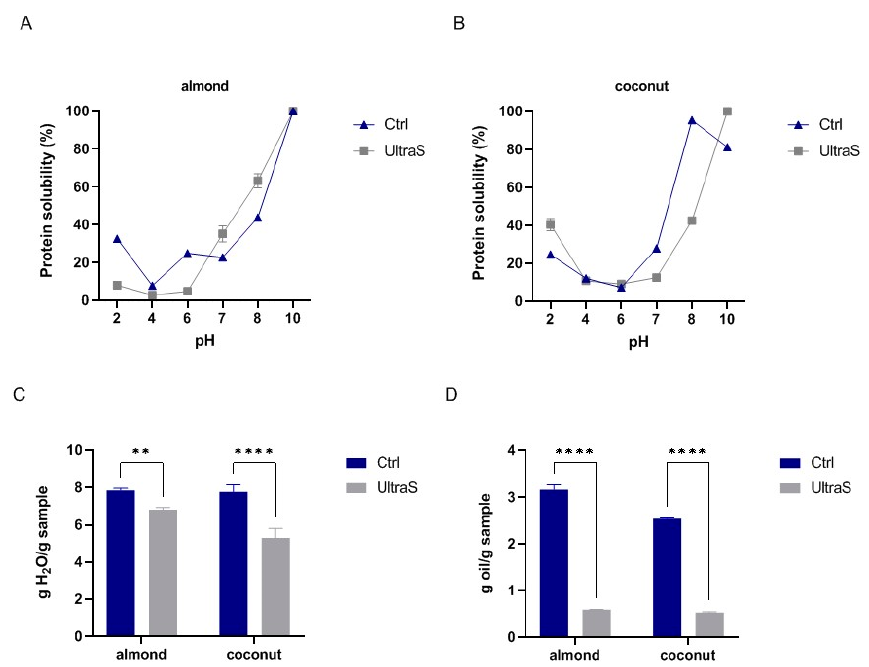
Figure 4. Protein solubility before and after the UAE for ( A ) almond and ( B ) coconut samples. ( C ) Water binding capacity and ( D ) oil binding capacity of untreated and treated samples. The data are represented as the means ± s.d. of three independent experiments. All data sets were analyzed by two-way ANOVA followed by Šídák’s multiple comparisons test. CTRL: control sample. (**) p < 0.01, (****) p < 0.0001.